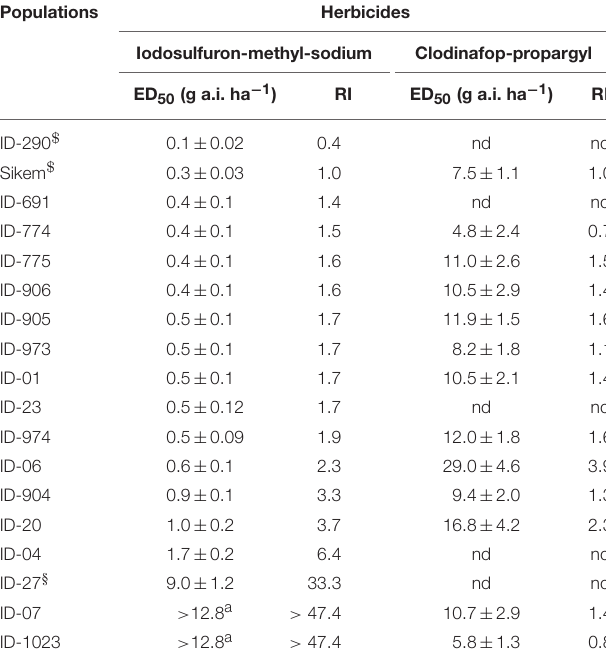
TABLE 2 | Dose response study of L. multiflorum populations using an ALS (iodosulfuron-methyl-sodium) and an ACCase (clodinafop-propargyl) inhibitor